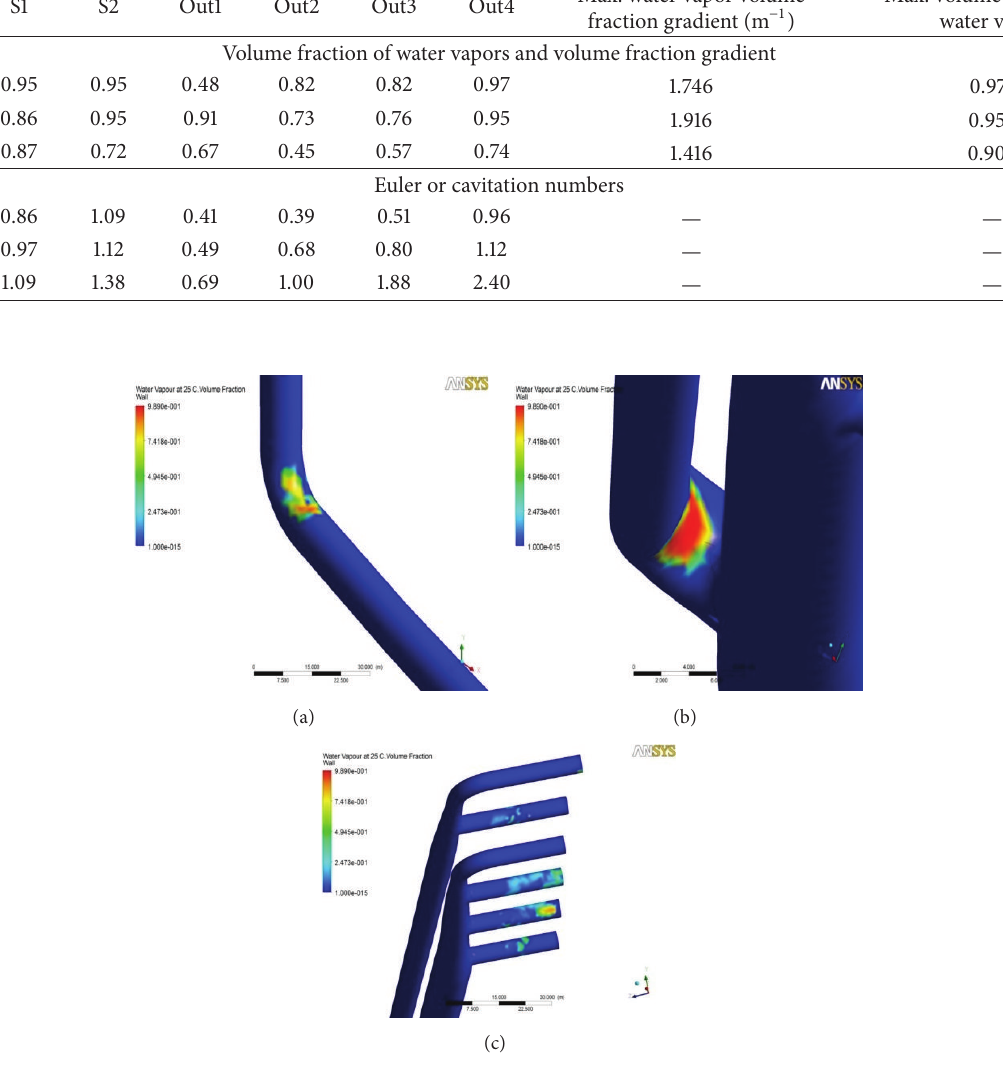
Figure 5: Cavitation erosion (water vapors) at different locations of Tunnel